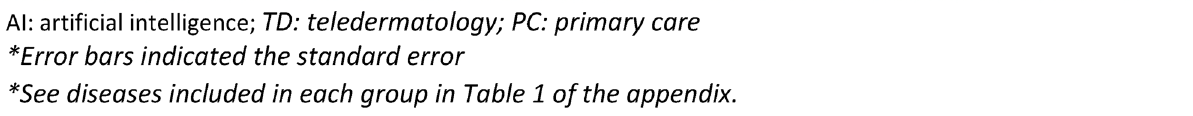
Figure 4. Mean sensitivity grouped by disease subgroups, only of the 82 cases recognised by the ML model.